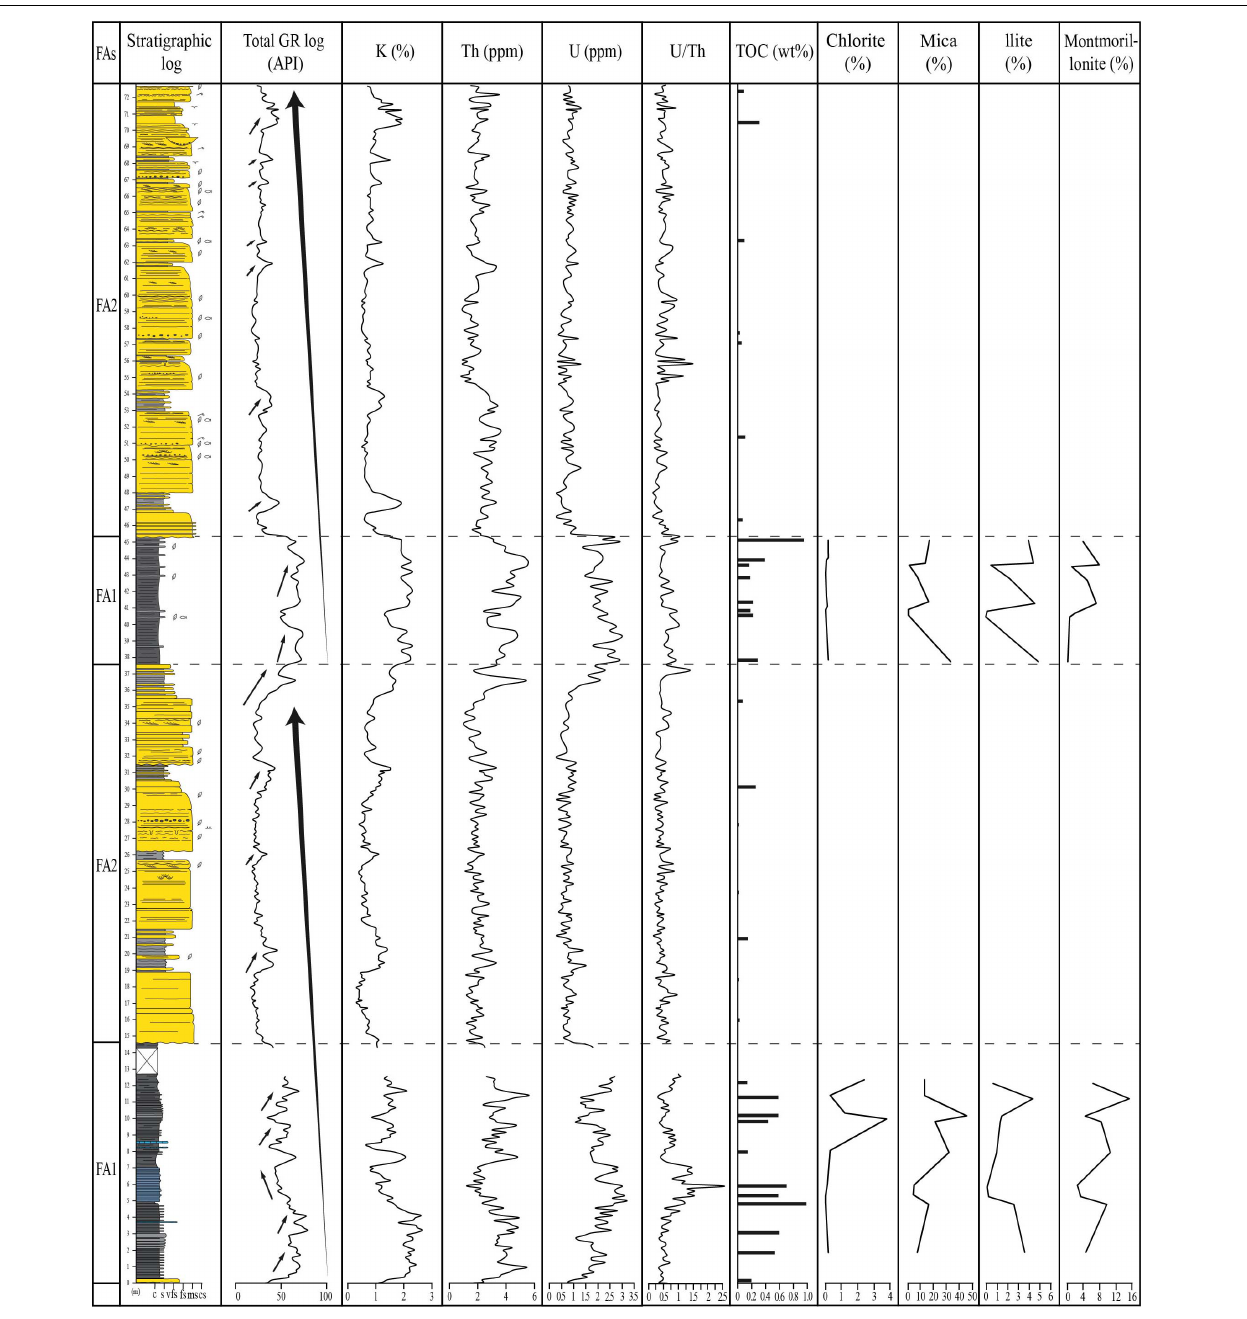
FIGURE 8 | The lithology log of the studied section correlate with total and spectral gamma-ray logs composed of potassium (K), thorium (Th), uranium (U), U/Th ratios including the TOC abundance from the representative samples throughout the section. Facies association boundaries are presented in dash line. Two major coarsening upward cycles (large arrows) and several minor trends (small arrows) of the sections can be observed mainly from total gamma-ray log in correlation with the sedimentary facies from stratigraphic log. The abundances of clay minerals including chlorite, mica, illite and montmorillonite from mudstone samples are also included to provide the correlation with the other logs in the